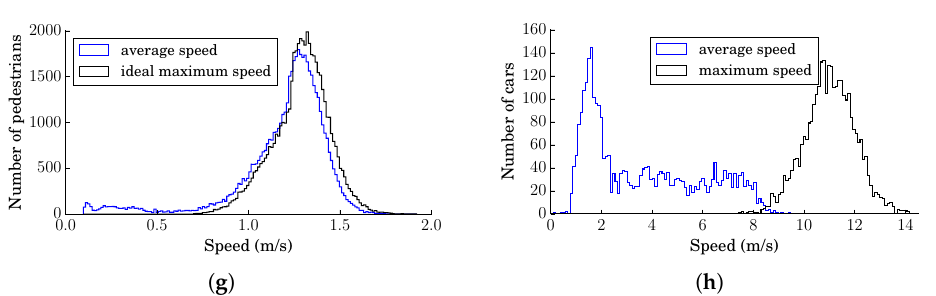
Figure 12. Speeds of pedestrian and car agents. Black indicates the theoretical maximum assuming the agent moves at its maximum speed, and blue indicates the average speed of the simulation. ( a ) Speed of pedestrians (6% car users), ( b ) Speed of cars (6% car users), ( c ) Speed of pedestrians (9% car users), ( d ) Speed of cars (9% car users), ( e ) Speed of pedestrians (15% car users), ( f ) Speed of cars (15% car users), ( g ) Speed of pedestrians (15% car + route restrictions), ( h ) Speed of cars (15% car + route restrictions).